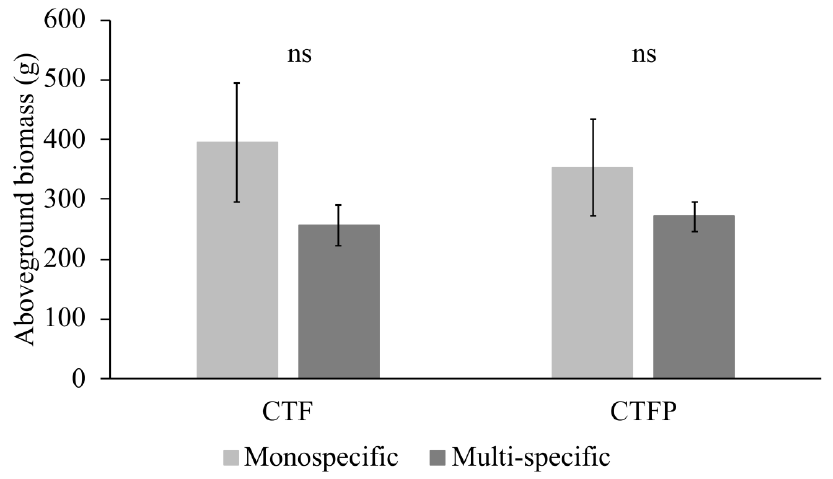
Figure 3. Differences in biomass productivity between the mean of the monospecific communities and the multi-specific communities. The bars represent the mean ± standard error. Significance level: ns = not significant.